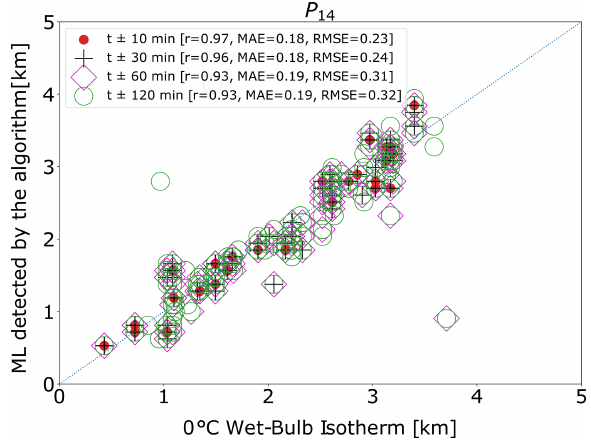
Figure 12. Heights of the 0 ◦ C wet-bulb isotherm versus ML esti- mated by the algorithm for several time windows using QVPs from 9 ◦ elevation scans. The 1:1 line is shown in blue. MAE and RMSE are given in kilometres.